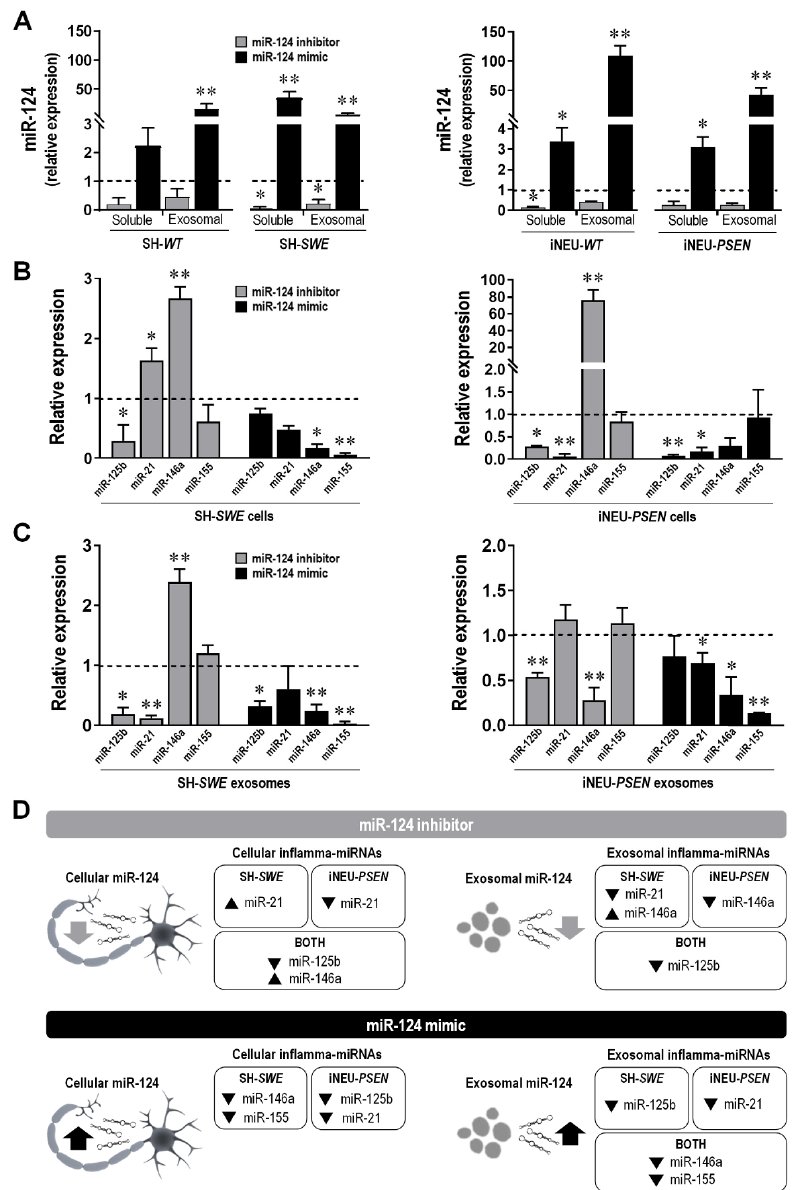
Figure 7. Transfection of SH- WT /SH- SWE and of iNEU- WT /iNEU- PSEN cells with miR-124 inhibitor and miR-124 mimic influences miR-124 representation in the vesicle-free secretome (soluble) and packaging into exosomes, while also modifies the representation of other inflamma-miRNAs in the same cells and respective exosomes. ( A ) Evaluation of the influence of the cell treatment with miR-124 inhibitor and miR-124 mimic in the release of miR-124 into the secretome, as a soluble species and as a exosomal cargo. ( B ) Evaluation of cellular inflamma-miRNA expression levels after modulation of miR-124 with its mimic and inhibitor. ( C ) Evaluation of exosomal inflamma-miRNA expression levels after cellular modulation of miR-124 with its mimic and inhibitor. ( D ) Schematic representation of cellular and exosomal inflamma-miRNA distribution in the classical and in the advanced neuronal AD models by miR-124 inhibitor and miR-124 mimic. Results are mean ± SEM fold change from at least three independent experiments. * p < 0.05 and ** p < 0.01 vs. respective mock controls, one-way ANOVA with Bonferroni post-hoc test. miR, miRNA; SH- WT , human SH-SY5Y wild-type neurons; SH- SWE , human SH-SY5Y expressing the APP695 Swedish mutant protein; iNEU- WT , iNeurons derived from induced pluripotent stem cells (iPSCs) generated from a healthy control; iNEU- PSEN , iNeurons from iPSCs generated from a patient carrying the PSEN1 ∆ E9